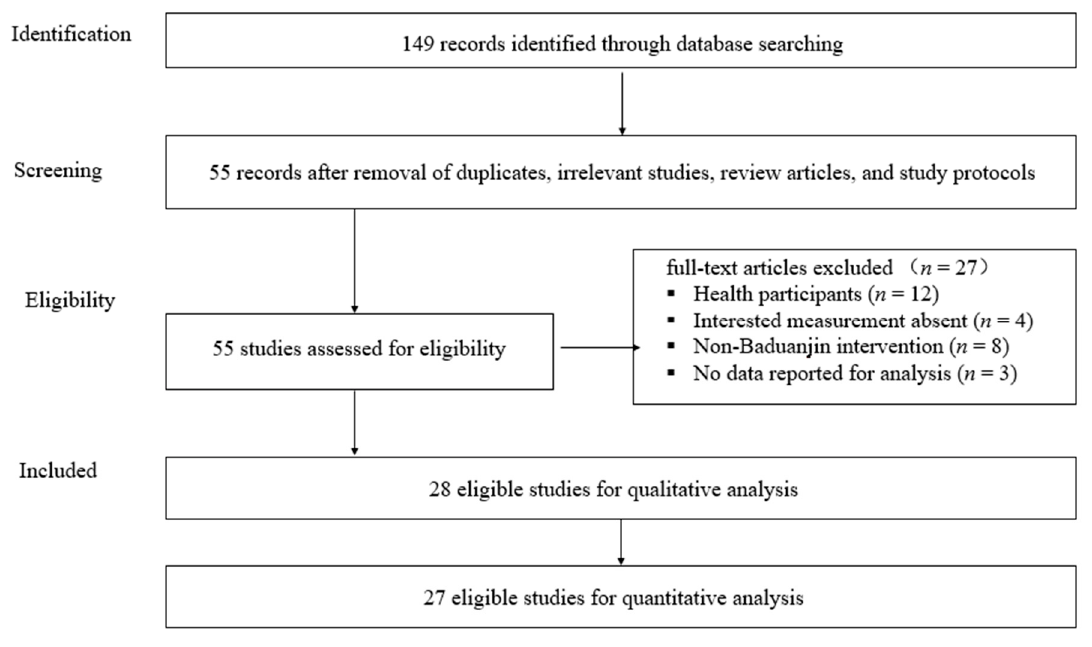
Figure 1. Flow of literature search and selection process.